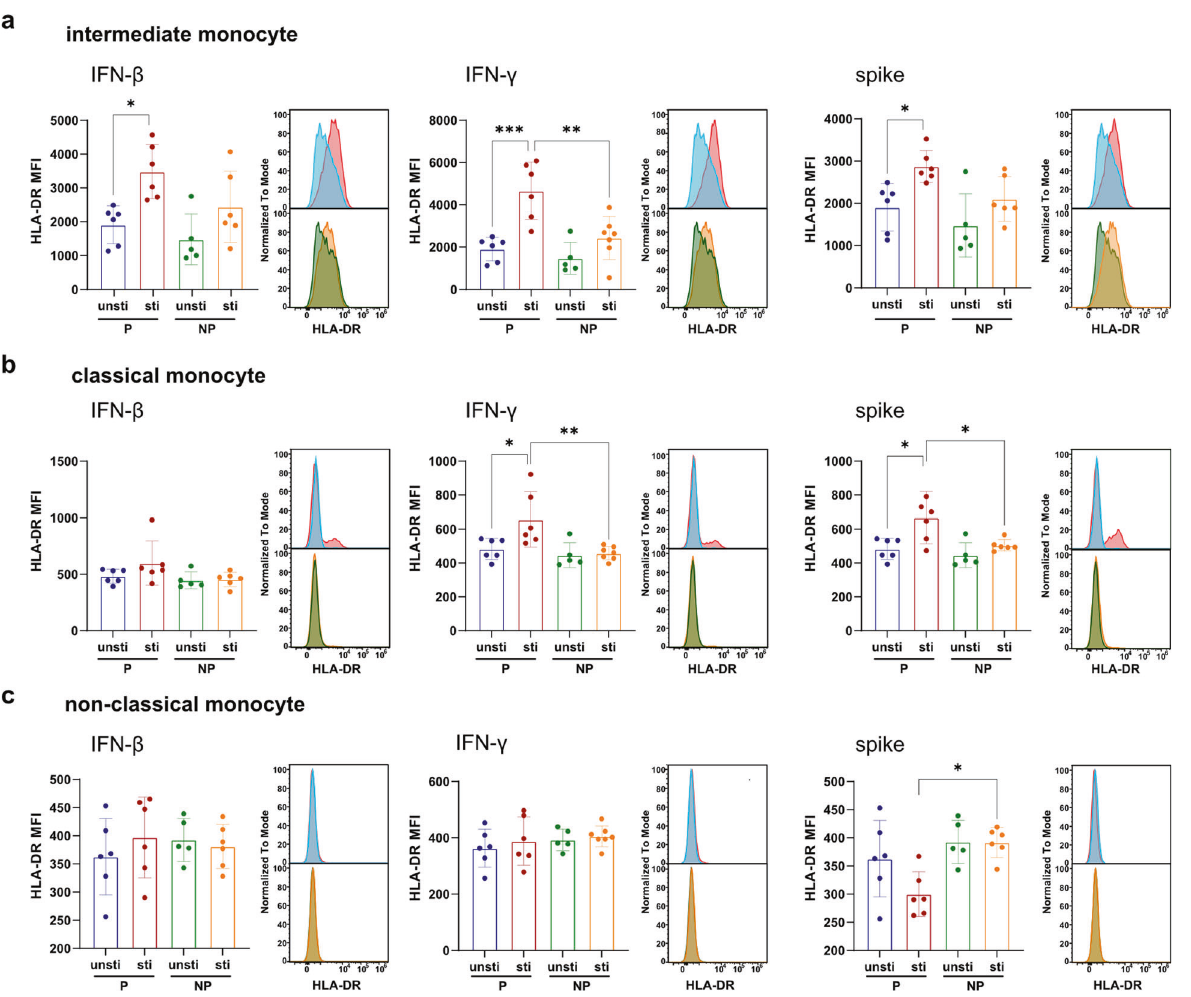
Fig. 7 Validation of in fl ammatory features combined with IFN response of pregnant women by in vitro experiment. a – c Comparison of the MFI (mean fl uorescence intensity) HLA-DR in intermediate, classical, and non-classical monocyte in stimulated compared to unstimulated blood samples by box plot and histogram. Freshly isolated blood samples withdrawn from pregnant ( n = 6) and non-pregnant healthy controls ( n = 6) were incubated with 1000 U/mL IFN- β , 1000 U/mL IFN- γ , or 25 ng/mL SARS-CoV-2 spike protein for 24 h. unsti unstimulated samples, sti stimulated samples. Barchart show median and interquartile range (IQR). Each dot represents an individual. Wilcoxon rank-sum test, adjusted for Bonferroni post hoc. * p < 0.05, ** p < 0.01, *** p <